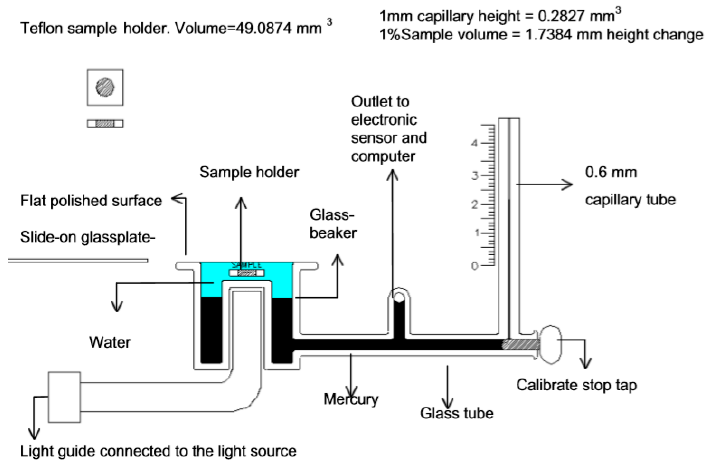
Figure 3. Schematic image of the glass parts of a dilatometer and the Teflon sample holder (top left). Reprinted from reference [23], published first on 4 December 2001. © IOP Publishing. Reproduced with permission. All rights reserved.